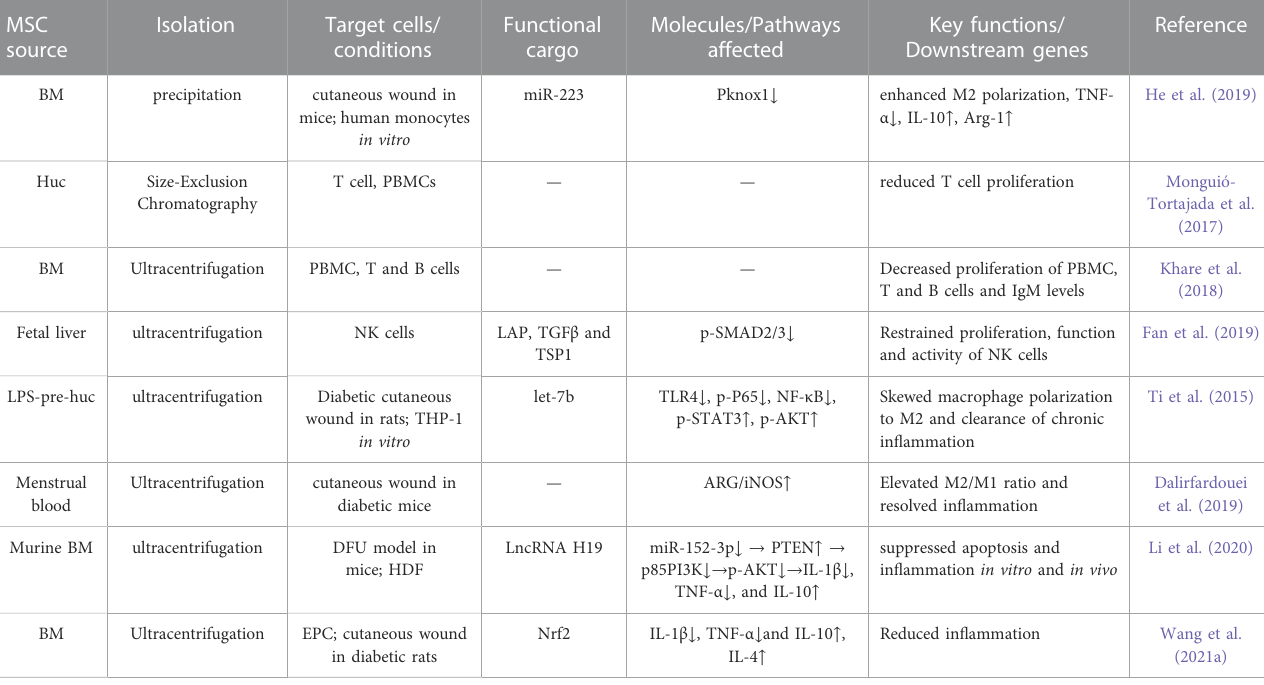
TABLE 3 MSC-sEVs play an active role in regulating in fl ammatory cells. MSC